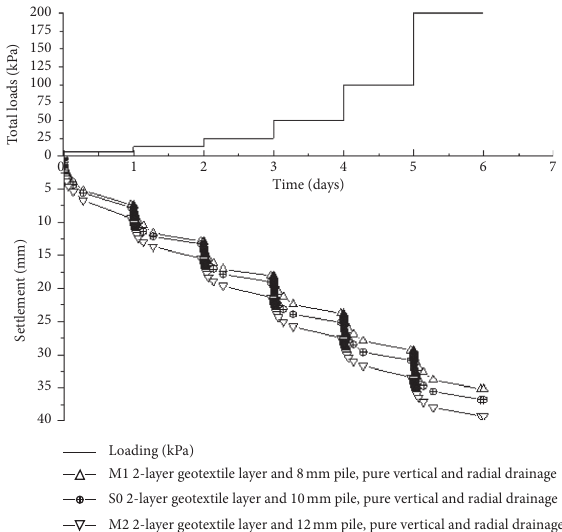
Figure 8: Relationships between consolidation settlement and time under each step loading for tests of Group B (M1, S0, M2).